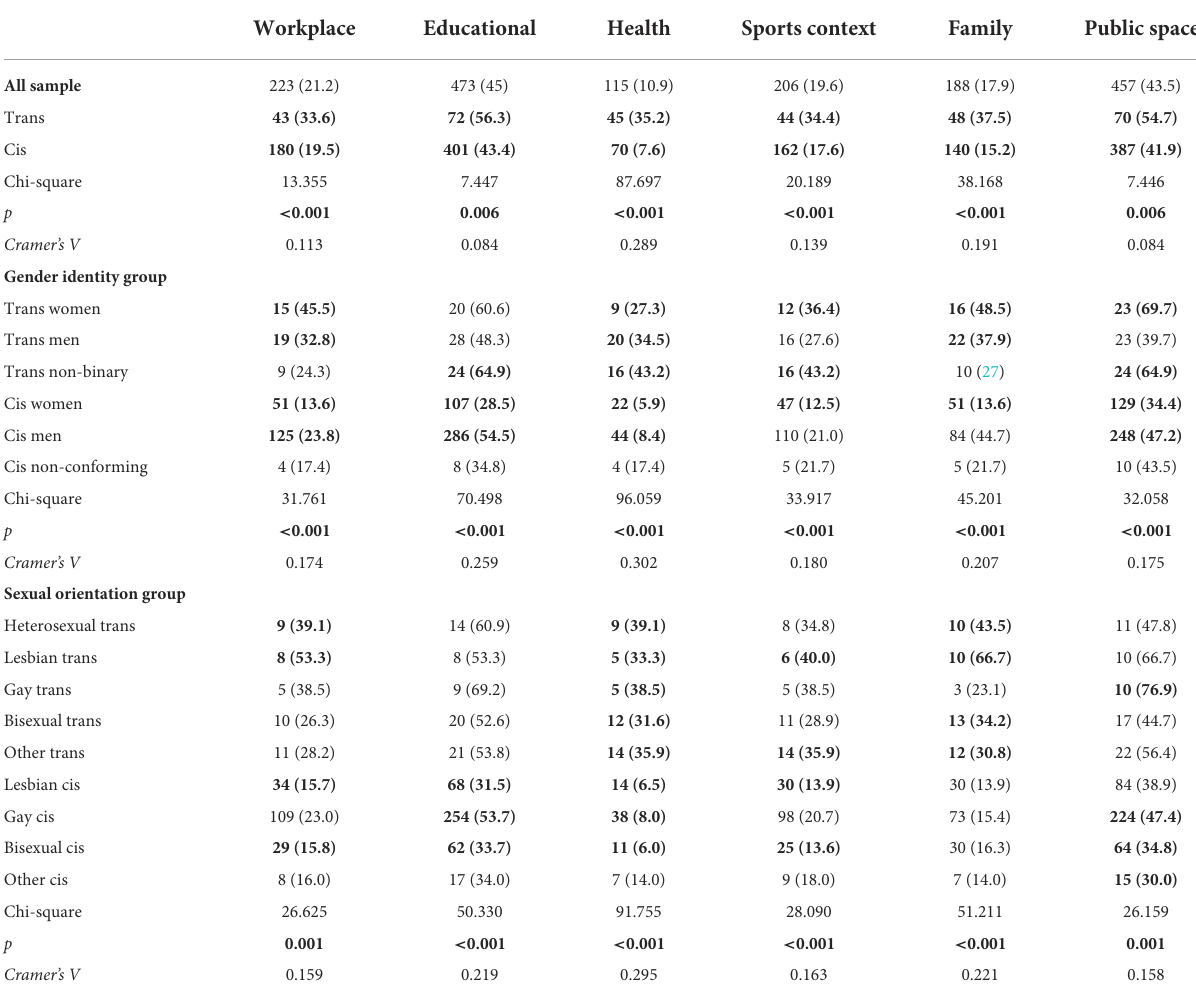
TABLE 2 Harassment contexts by gender identity and sexual orientation